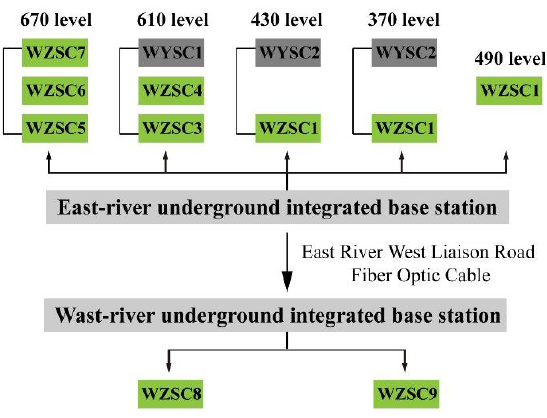
Figure 1. Structure diagram of microseismic monitoring system. Green and gray represent drilling and measurement points .